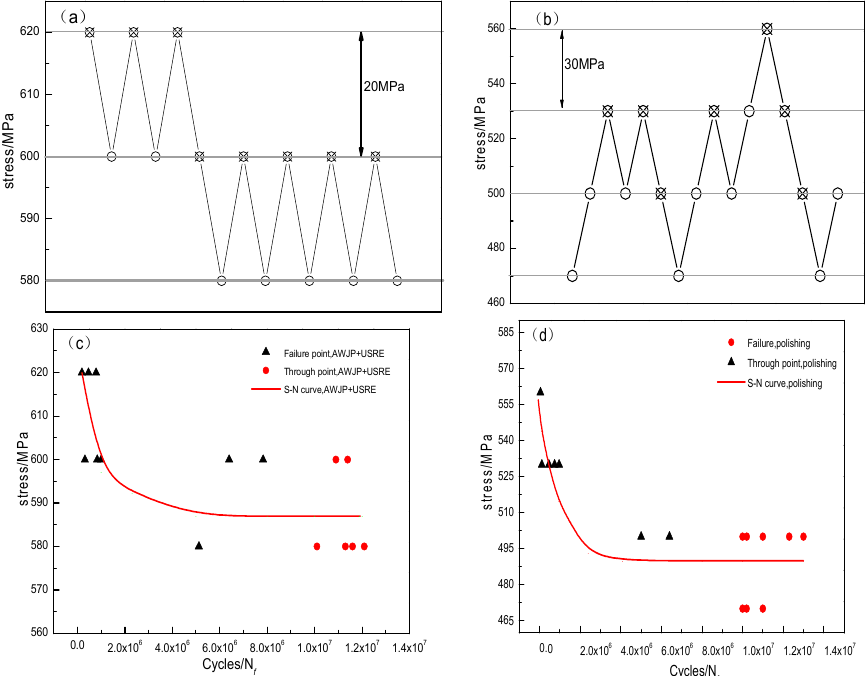
Figure 4. The fatigue limit of 4340 steel processed with ( a ) 13% abrasive water jet peening (AWJP) +